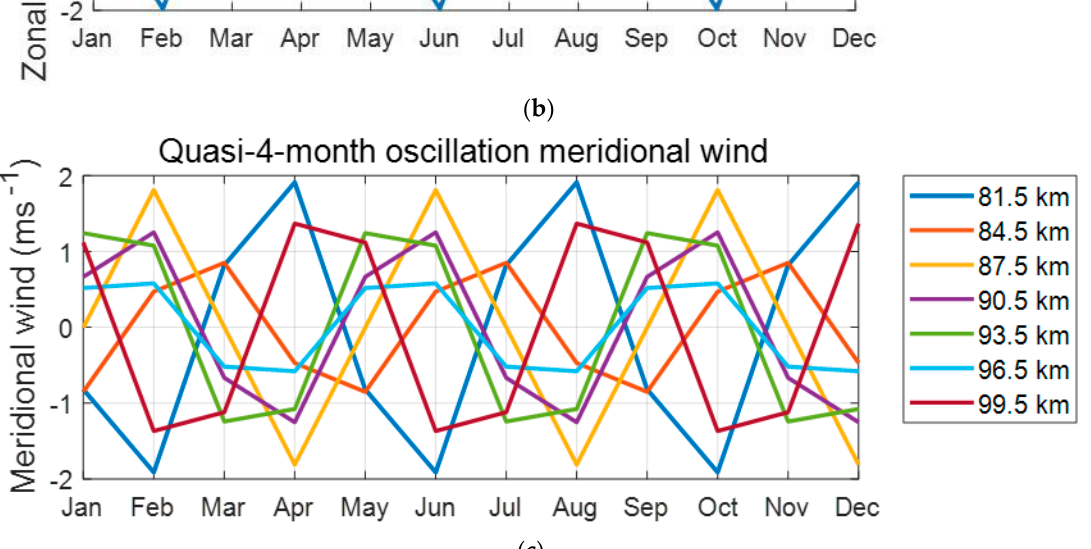
Figure 8. The observed and estimated acceleration for quasi-4-month oscillation zonal winds. Jan